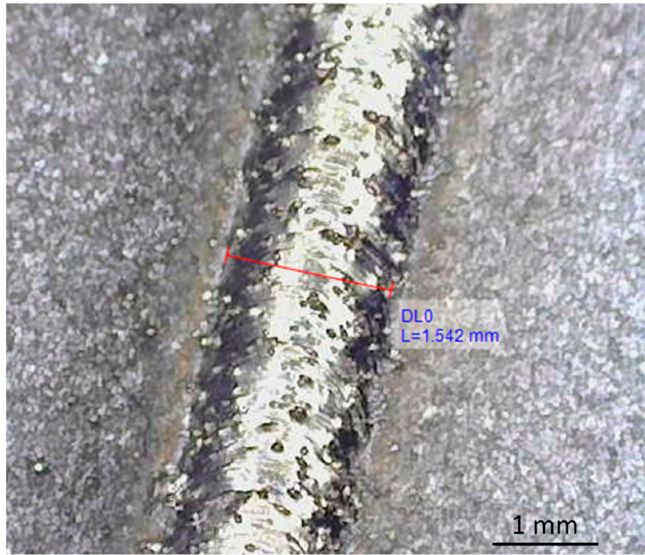
Figure 4. Single line traced by LMD using the optimized conditions from Table 1.